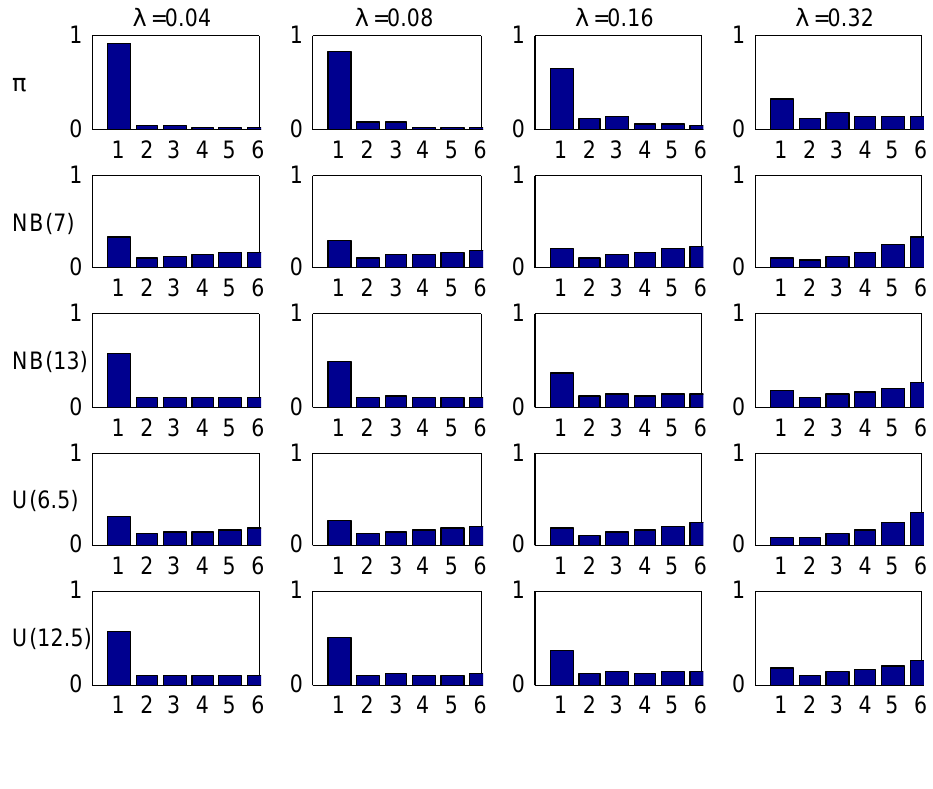
Figure 5. Stationary and age-corrected distributions,